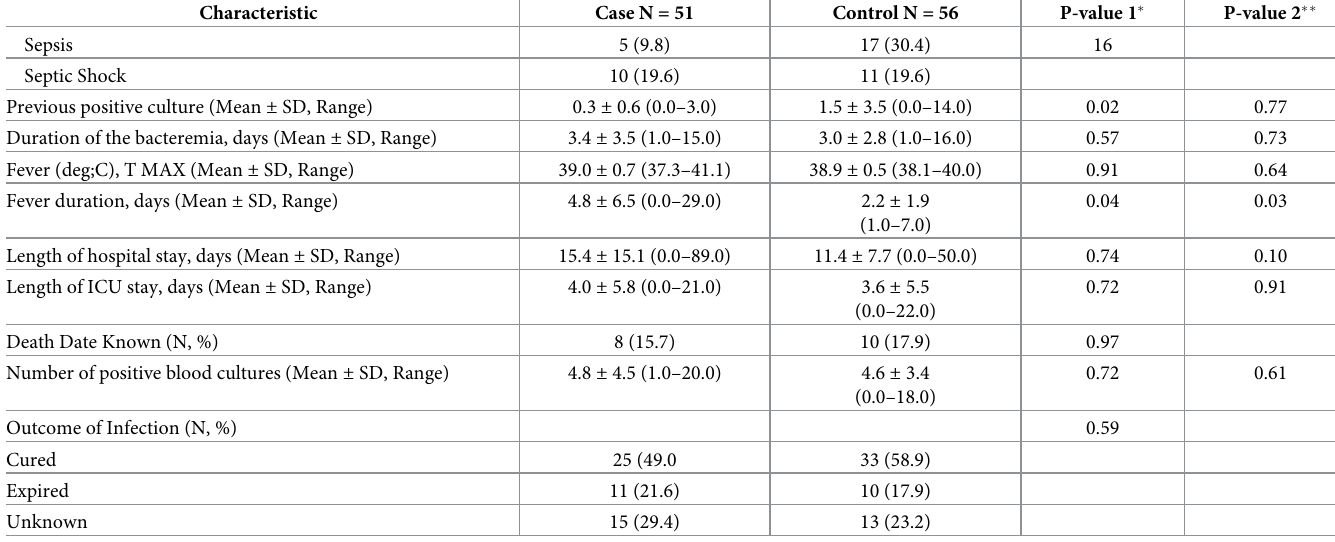
Table 4. Clinical outcomes by PVL Case/Control